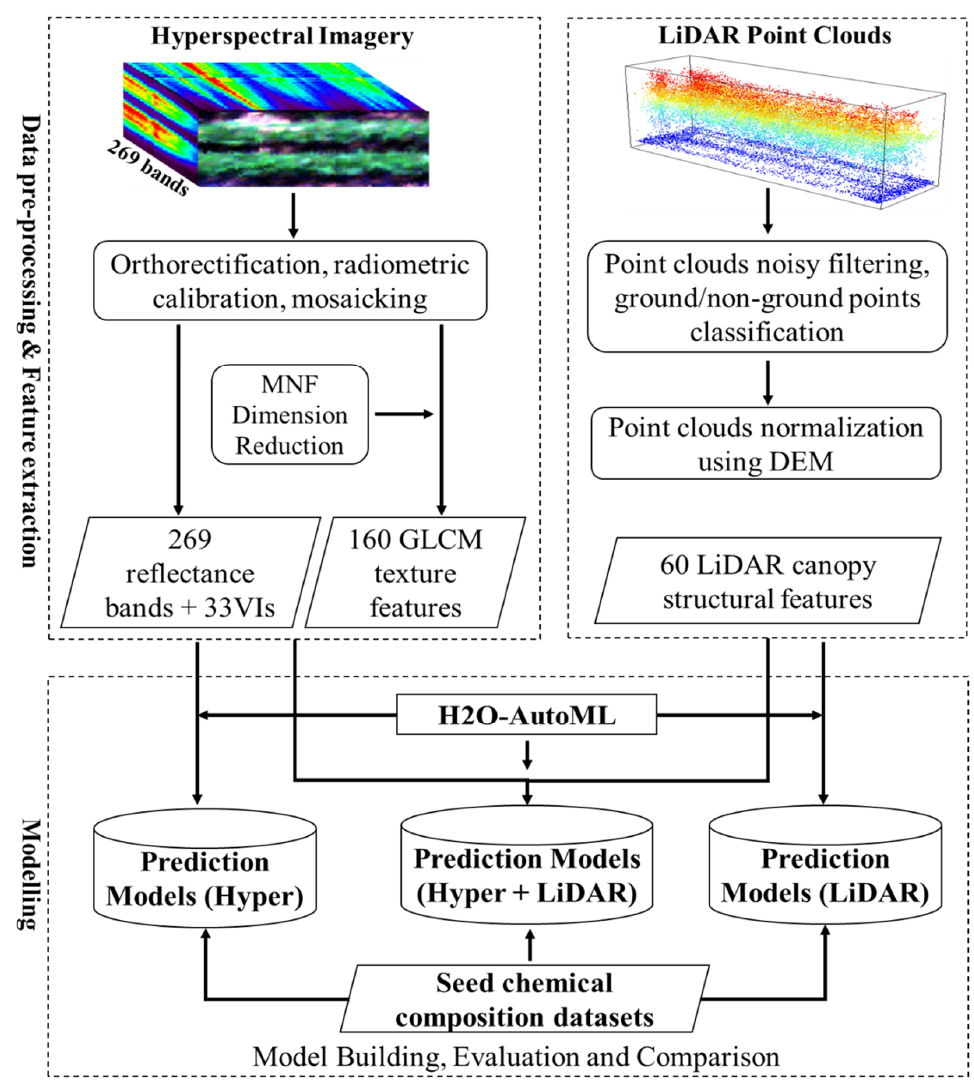
Figure 6. Workflow of hyperspectral and LiDAR data processing, feature extraction and implement- ing automated machine-learning methods.The figure modified after [43] .